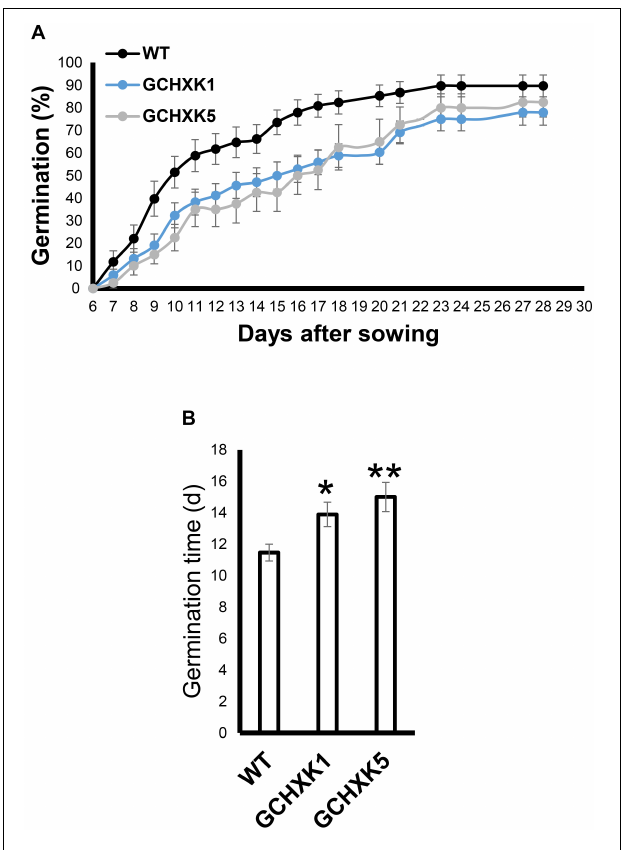
FIGURE 9 | GCHXK seeds germinate more slowly than WT seeds. The germination rates of the different seeds were examined by sowing 68 seeds of the WT and GCHXK1, and 40 GCHXK5 seeds. The seeds were divided into groups of four, and the percentage of seeds that germinated was calculated from the average of the groups. (A) Percentage of seed that germinated over 28 days. (B) Average time to germination of WT, GCHXK1, and GCHXK5 seeds. Data are displayed as means ± SE. Asterisks denote significant differences relative to the WT ( t -test, * P < 0.05; ** P < 0.01).